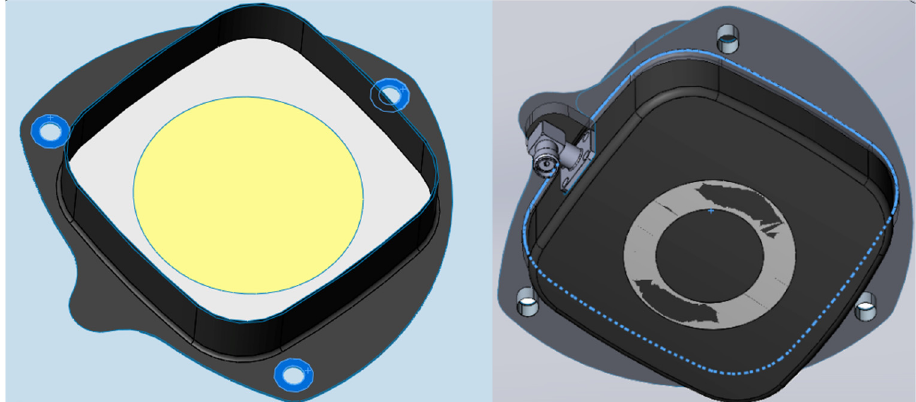
Figure 8. Boundary conditions—fixation of bolt heads in upper half-cycle ( left ) and support contact edge in bottom half-cycle ( right ).